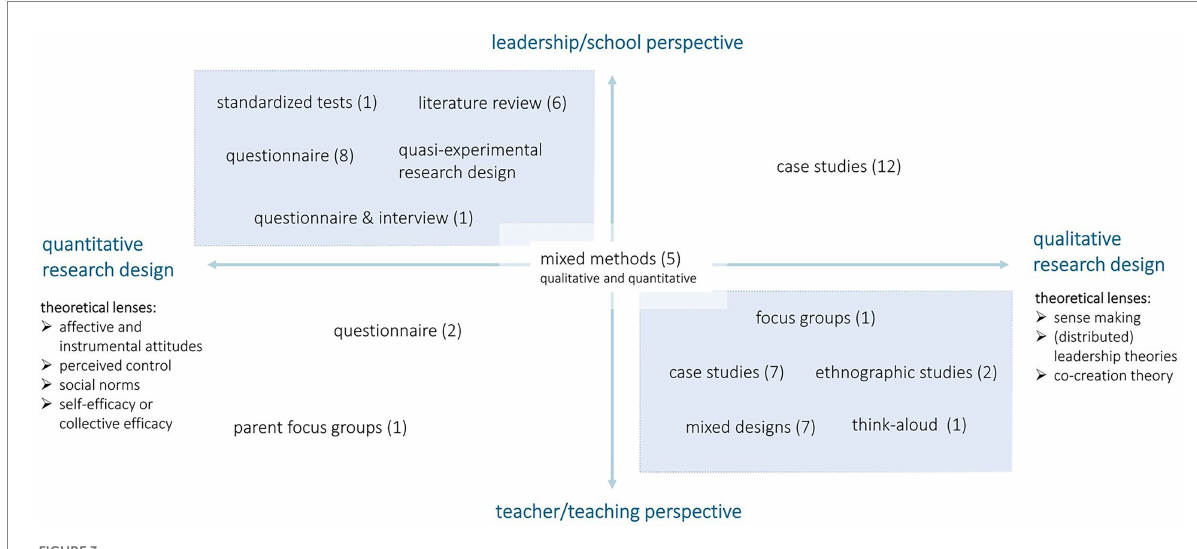
FIGURE 3 Research designs and methodological frameworks (reported) in the empirical